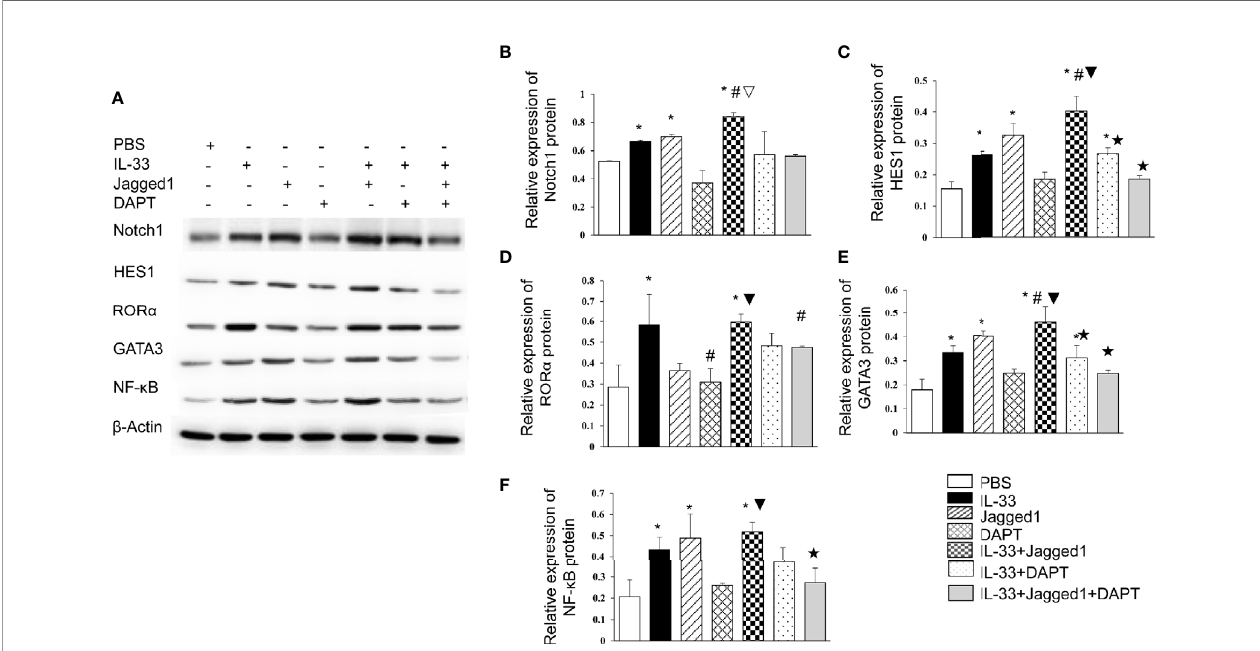
FIGURE 4 | Protein levels of Notch1, Hes1, ROR a , GATA3 and NF- k B in different groups. The protein expressions of Notch1, Hes1, ROR a , GATA3 and NF- k B in the supernatant of PBS group, IL-33 stimulation group, Jagged 1 treatment group, DAPT treatment group, IL-33 + Jagged 1 treatment group, IL-33 + DAPT treatment group were determined by Western Blot. (A) Representative Western blot results of ROR a , Notch1, Hes1, GATA3 and NF- k B in each treatment group. Expression of (B) Notch1, (C) Hes1, (D) ROR a , (E) GATA3, and (F) NF- k B was measured by Western Blot relative to b -actin. Data are shown as mean ± SEM. n=10. *P < 0.05 compared with PBS group, # P < 0.05, compared with IL-33 group, ▽ P < 0.05 compared with Jagged1 group, ▼ P < 0.05 compared with DATP group, ★ P < 0.05 compared with IL-33+Jagged1 group.